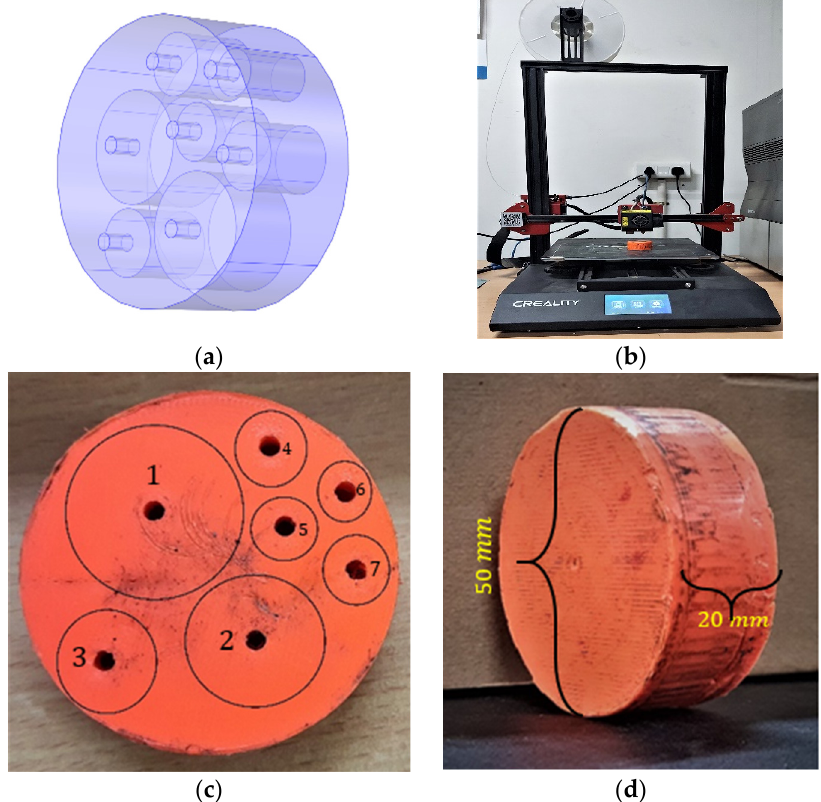
Figure 3. ( a ) Solid works model of metamaterial plate; ( b ) fabrication using a 3D printer; ( c ) top view of the manufactured metamaterial plate; ( d ) side view of the metamaterial plate. Table 1. Resonance frequency and diameter of different cavities for Helmholtz resonators .